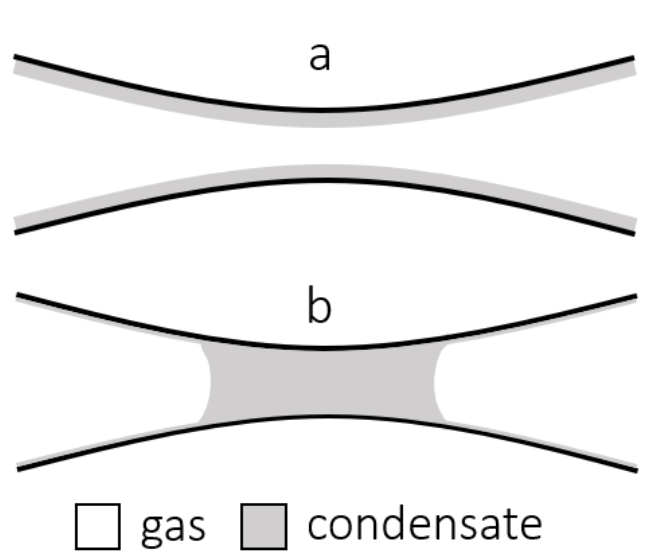
Figure 2. Stages of condensation and flow in a liquid-wet capillary. ( a ) Film of liquid at initial state of condensation. ( b ) Slug of liquid formed after snap-off.